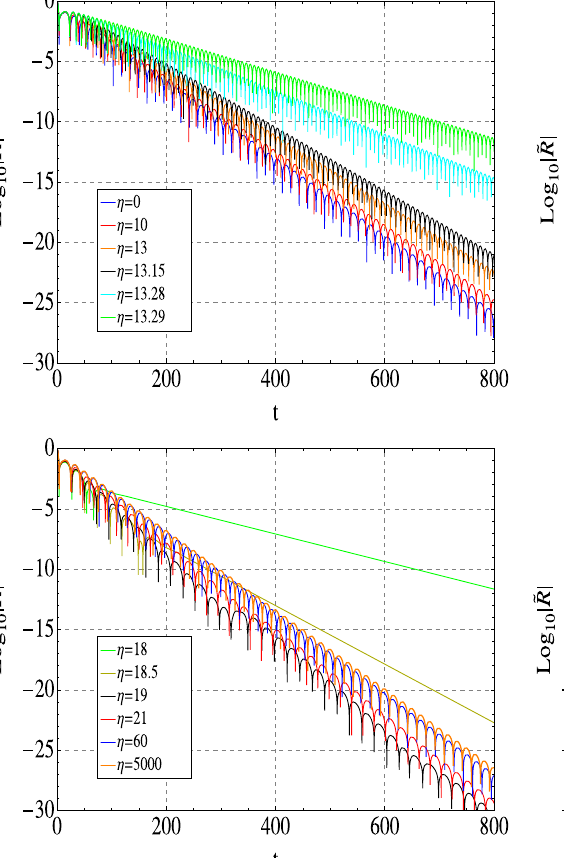
The critical charge related to the formation of region (v) for the chosen parameters is Q c ∼ 0 . 777. In the lower-right panel we see the massive field profile with